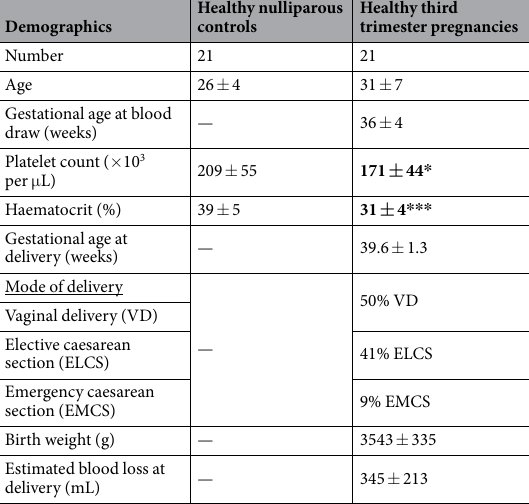
Table 1. Demographics of healthy non-pregnant controls compared with healthy third trimester pregnancy participants. Data are presented as mean ± SD; * p < 0.05 and *** p <